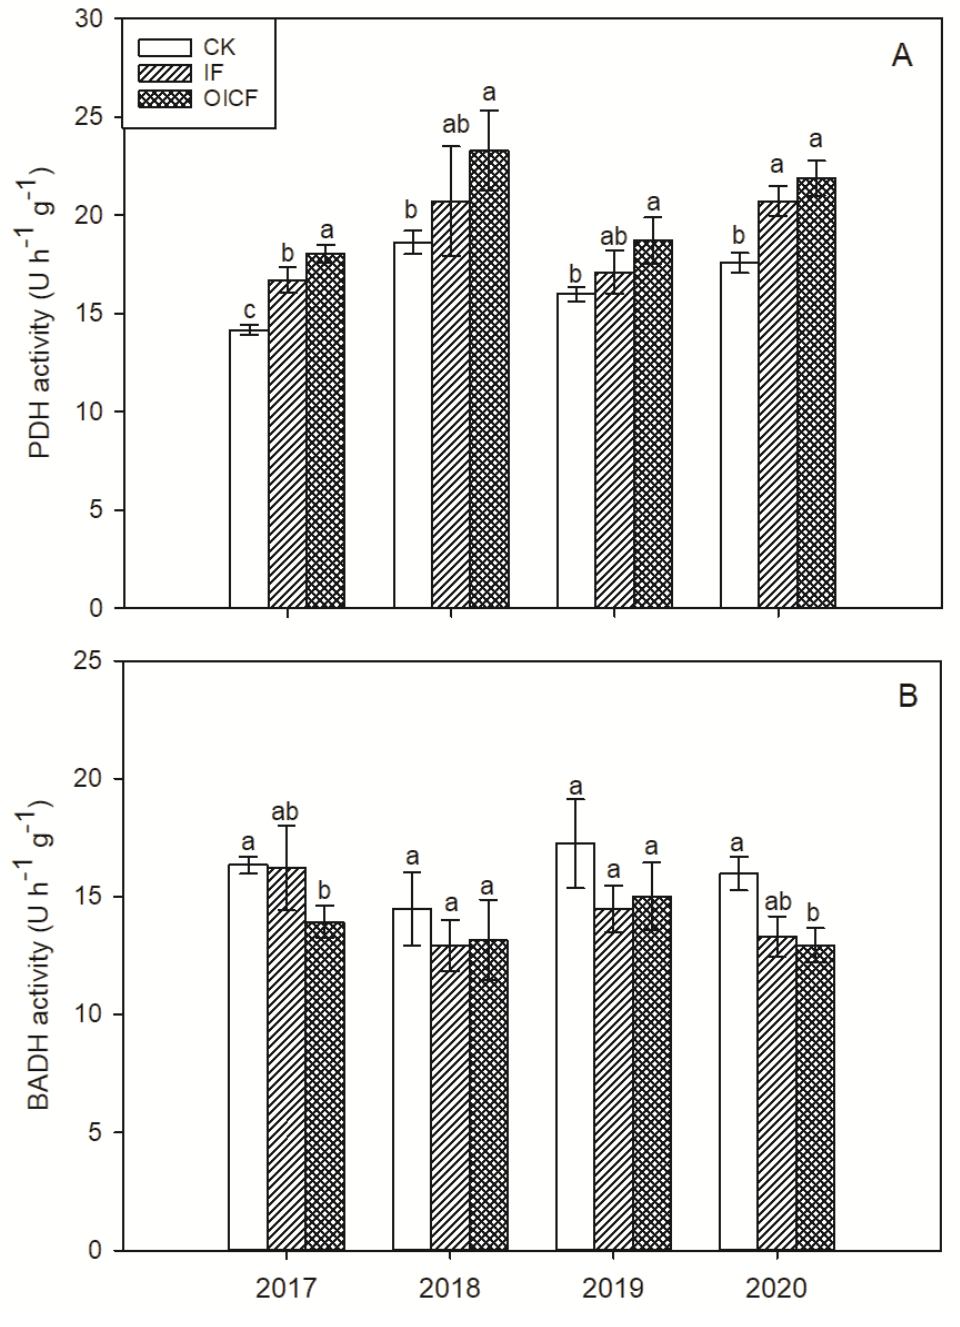
Figure 6. Effects of new organic-inorganic compound fertilizer on activities of PDH ( A ) and BADH ( B ) in fragrant rice. Bars sharing a common letter do not differ significantly at p ≤ 0.05.